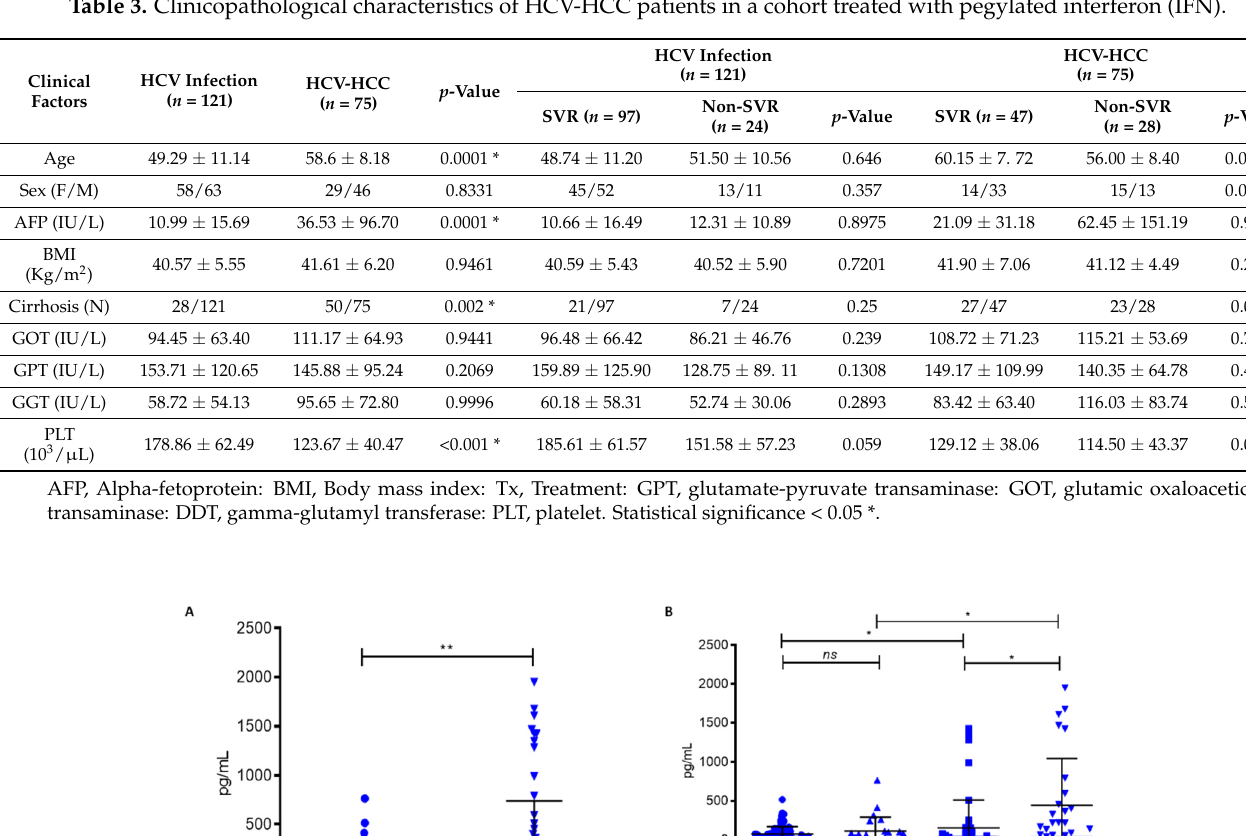
Figure 6. The Search Tool for the Retrieval of Interacting Genes (STRING) protein–protein interac- tion (PPI) network of our candidate genes, SRC and CXCL8 , their interaction with cancer signatures, and their expression. ( A ) PPI enrichment of CXCL8 and SRC, and their interaction with signature genes EDN1 , CEBPD , and CTNNB1 ( p = 6.43 × 10 − 5 ). Q-PCR validation of cancer signature genes’ expression of ( B ) CTNNB1 , ( C ) EDN1 , and ( D ) CEBPD . Fold changes of mRNA levels (compared to mRNA levels of Huh7.5.1 control cells) are shown as ± SD from two-to-three independent experi- ments ( p < 0.05 * determined by paired t -tests) while values p > 0.05 were deemed non-significant (ns). 4. Discussion Hepatitis C virus replication in the liver is reflected by the amount of virus in the serum, which represents the amount of virus in the liver [25]. Direct-acting antiviral (DAA) therapy can effectively achieve SVR in HCV treatment, with a residual risk of HCC reported in patients with advanced liver disease and liver-disease related complications [26]. Various clinical and research studies have illustrated that HCV is capable of inducing HCC directly due to the functioning of proteins, or indirectly through the activation of chronic liver inflammation, which has assisted in the identification of candidate HCC tar- gets [27]. Another clinical study has demonstrated how the eradication of HCV with IFN- based treatment leads to the impairment of hepatocarcinogenesis; however, HCC may occur even after virus eradication [28]. Whether in cohorts exhibiting non-SVR with IFN/RBV treatment, or in untreated cohorts, the indication of HCV persistence in the liver